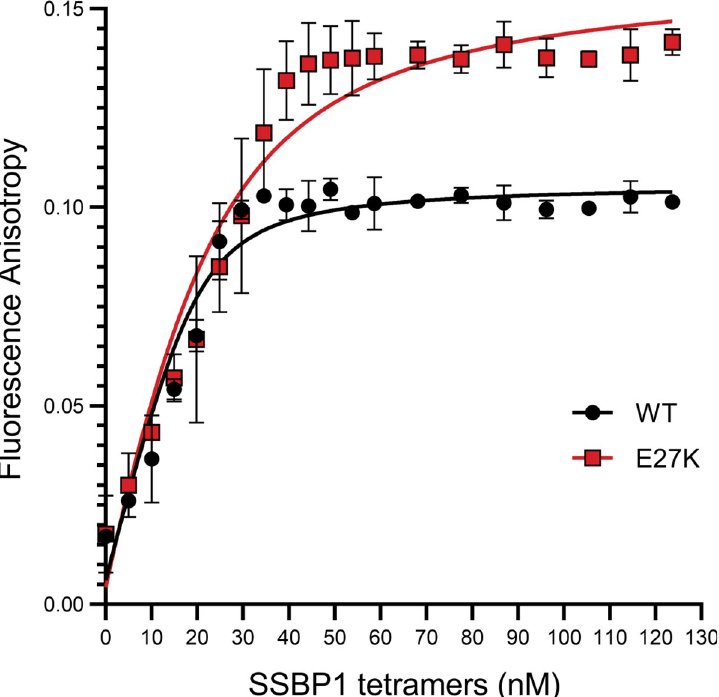
Fig 6. p.E27K SSBP1 binds ssDNA subtly differently than WT SSBP1. Changes in fluorescence anisotropy of 20 nM fluorescein-labeled 50 nucleotide ssDNA substrate were measured in response to the step-wise addition of WT or p. E27K SSBP1. Nonlinear regression fits are plotted as thick lines for each dataset. Protein concentration refers to tetramers. Error bars represent 95% confidence intervals; n = 3.